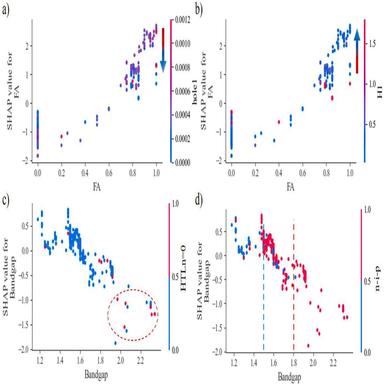
The effect of dual feature interactions on model decisions. The effect of two feature on the model (PCE:XGBoost) decision is analysed by adding a second feature to the dependence plot of a single feature. a) FA-associated transport material feature (hole), b) FA-associated transport barrier feature (H1), c) bandgapassociated cell architecture feature (HTLn = 0), d) bandgap-associated cell architecture feature (n-i-p/p-i-n).